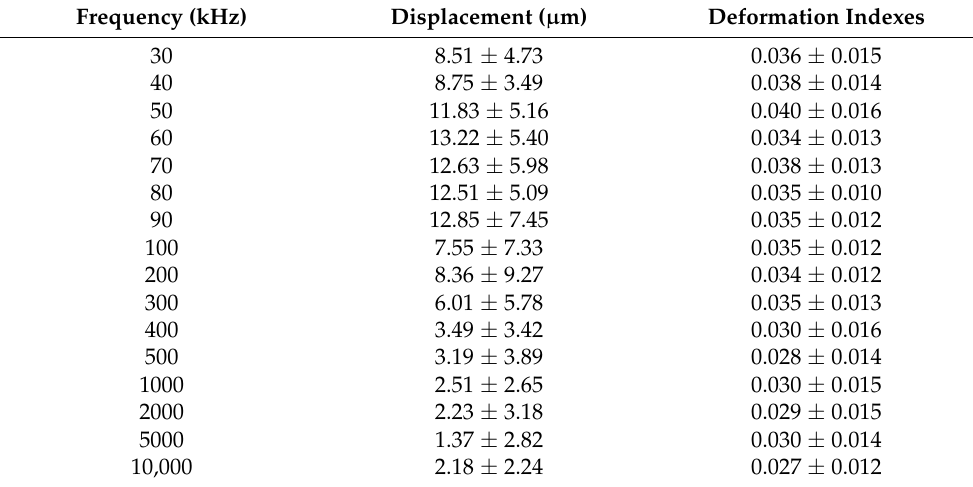
Figure 5. Dielectrophoretic deformation of U87 glioma cells. ( A ) Deformation of a cell at 3 V pp –50 kHz, 100 kHz, 500 kHz, and 1 MHz, ( B ) Deformation indexes of cells at 0 kHz–0 Vpp, and 3 V pp –30 kHz to 10 MHz. One-way analysis of variance test was applied. n = 100 cells, * = p < 0.05, *** = p < 0.001. Table 1. Dielectrophoretic displacements and deformation indexes of U87 glioma cells. Displacement and deformation values were represented by means ± STD, n = 100